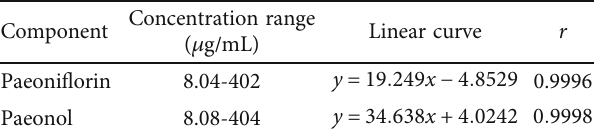
Table 2: Linear range and detection